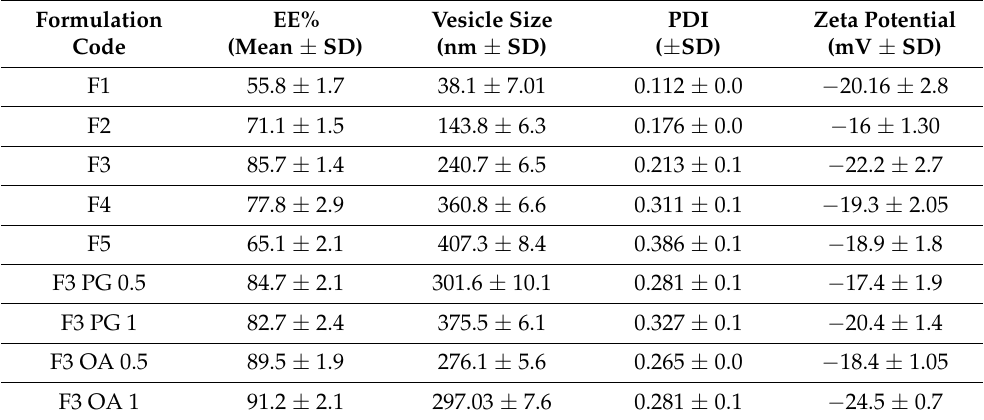
Table 2. Characterization of the formulated TCR-loaded